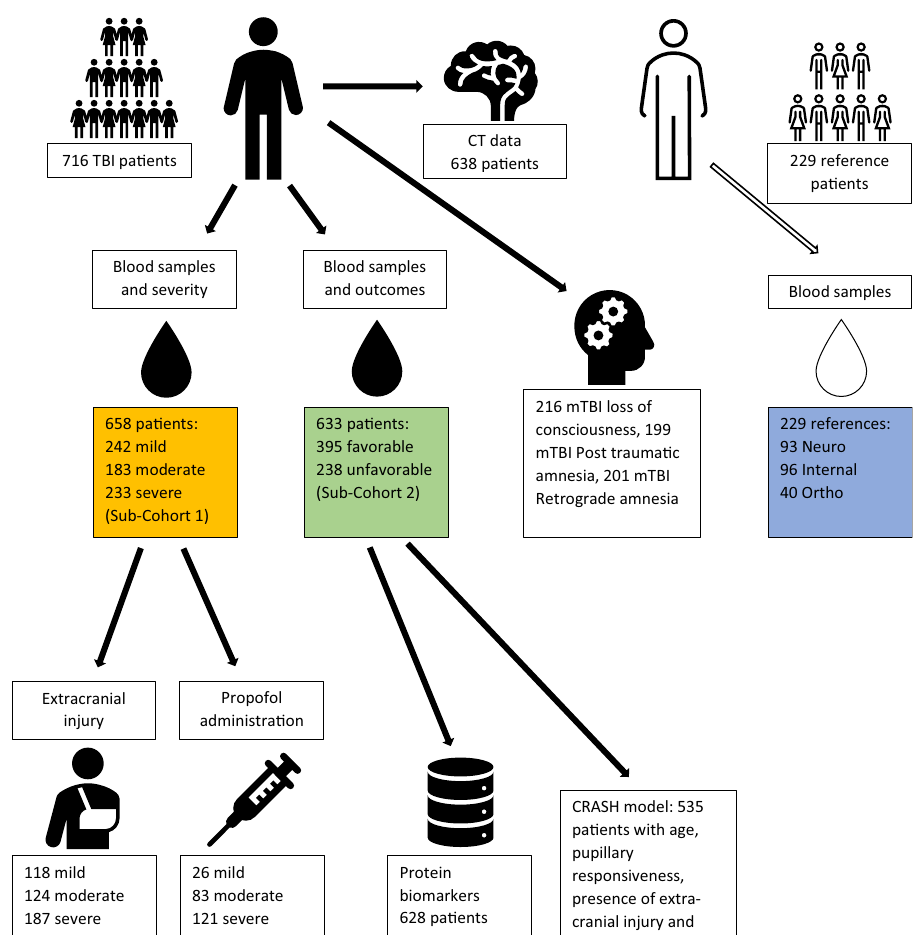
Fig. 1 The study setting. Black color denotes TBI patients and white color denotes reference patients. The TBI patients were from all three severity groups (mild, moderate, severe) and the reference patients were from three injury types: internal medicine, orthopedic, and neurological (blue box). The main analysis for severity discrimination was on patients for whom GCS scores were available (sub-cohort 1, yellow box) at baseline evaluation and the main analysis for outcome discrimination was on patients that had GOSe available (sub-cohort 2, green box). Most patients belong in both sub-cohorts. For the TBI-reference patient discrimination analysis data from sub-cohort 1 and the control patients were analyzed (yellow box plus blue box). Further sub- populations were examined from sub-cohorts 1 and 2, based on availability of more re fi ned data (extra-cranial injury, propofol administration, protein biomarkers, and variables necessary for the evaluation of the CRASH model). For the full TBI cohort associations between the metabolomic/lipid levels and CT fi ndings were made. Abbreviations: Neuro, patients with acute stroke or other neurological conditions; Internal, acute internal medicine illnesses (e.g., infections, cardiac symptoms, GI-symptoms) (Internal); Ortho, patients with acute orthopedic or other non-brain traumas; mTBI, mild